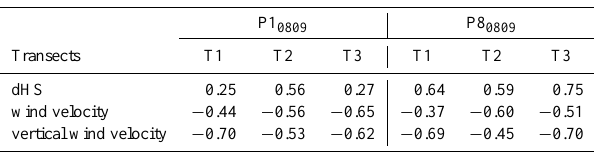
Table 2. Pearson’s linear correlation coefficient of measured snow depth change (dHS) against modeled dHS, wind velocity and verti- cal wind velocity P1 0809 P8 0809 Transects T1 T2